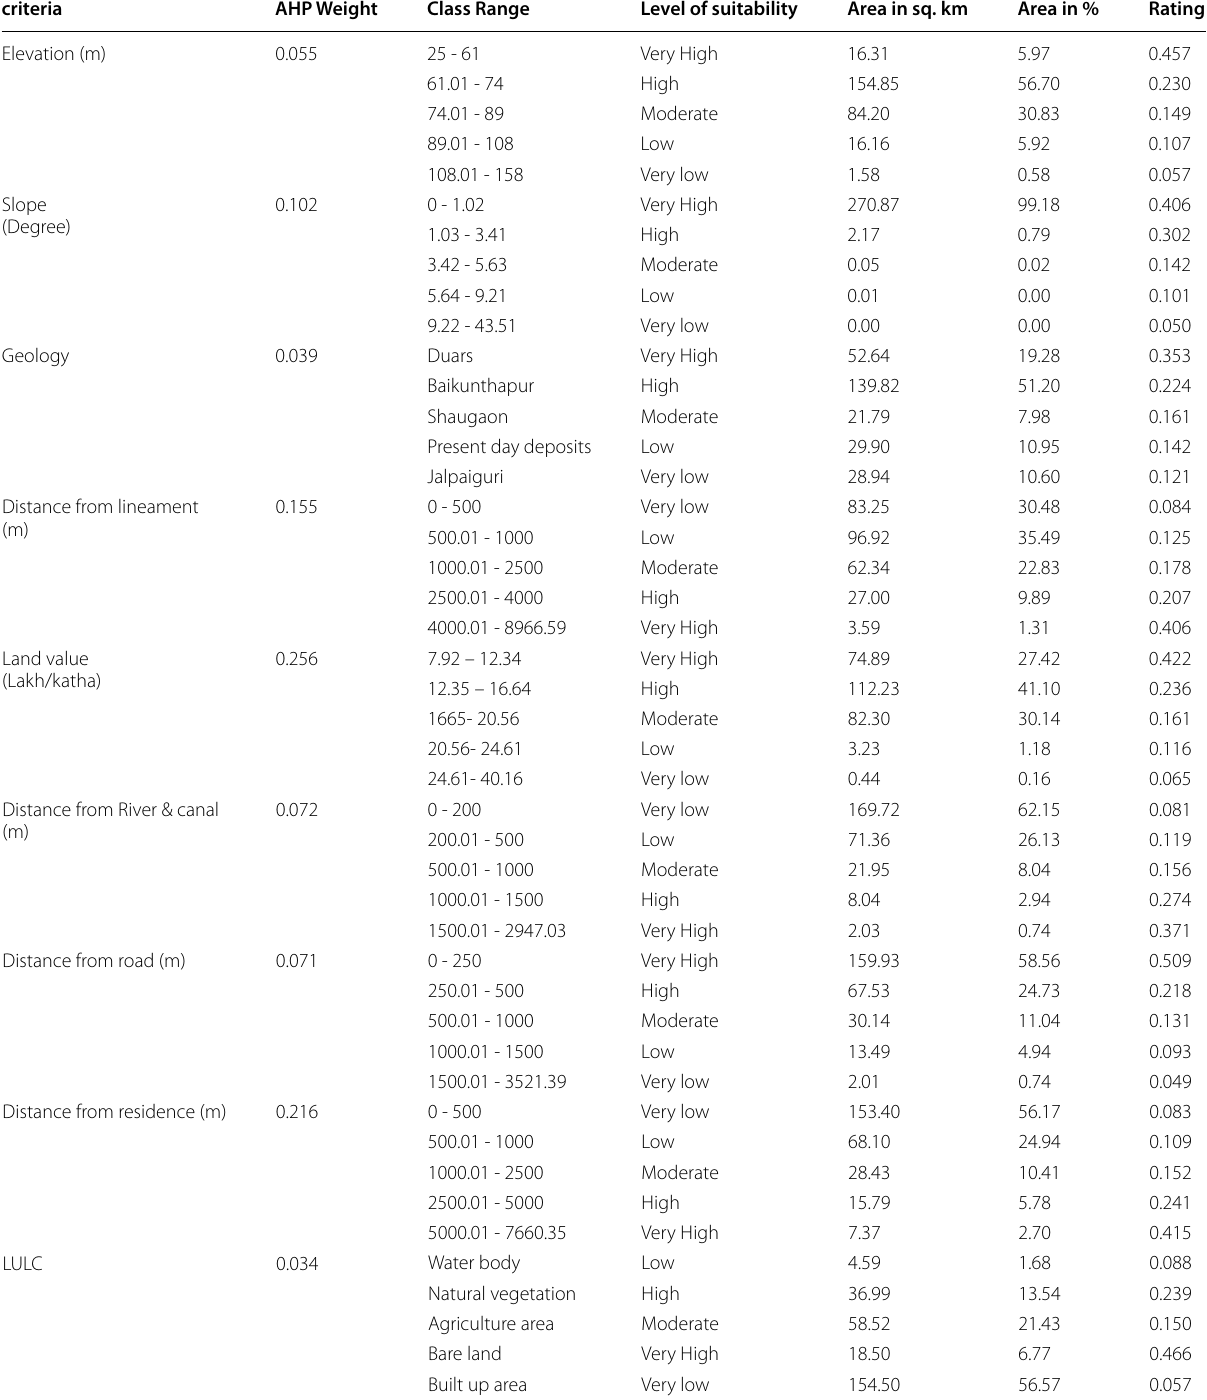
Table 12 Summary of criteria, AHP weight, Class range, level of suitability, Area in sq. km, Area in %, and rating of each criteria